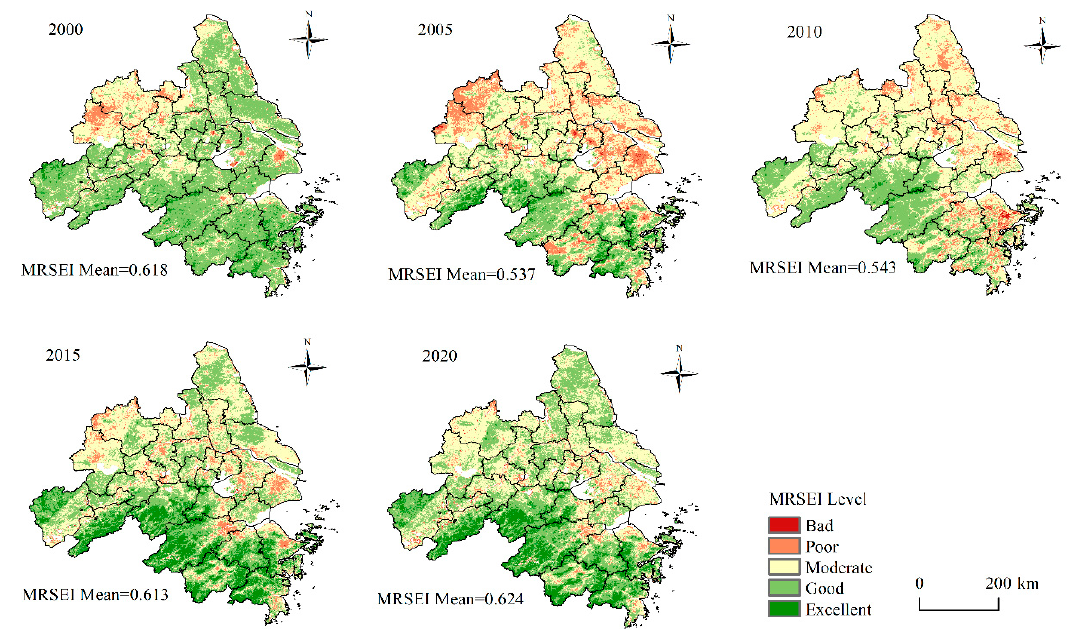
Figure 2. Spatial distribution of EEQ levels in the YRDUA from 2000 to 2020.